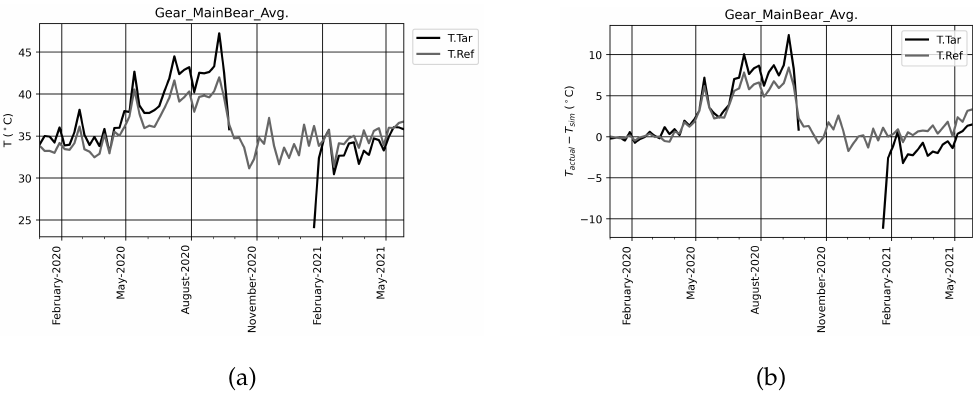
Figure 8. Main bearing temperature weekly average trend of raw data ( a ) and the error of the SVR model ( b